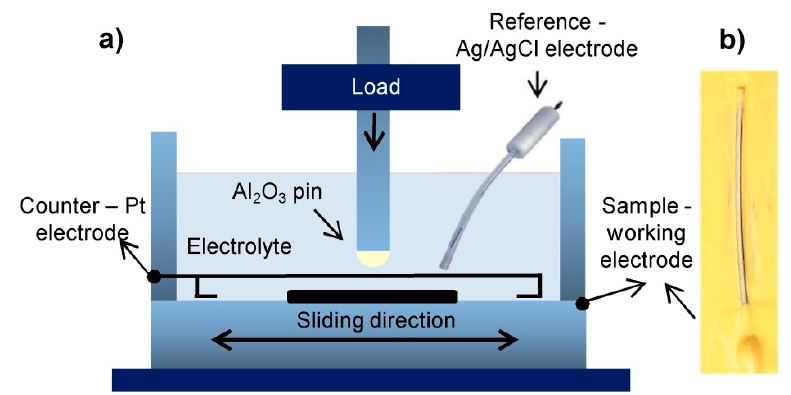
Figure 1. Experimental setup for the tribo-electrochemical investigation ( a ); a prepared working electrode from a section of the archwire for the tribo-electrochemical measurements ( b ).